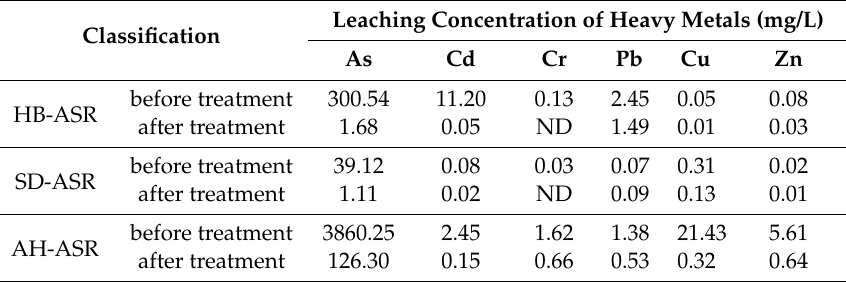
Table 6. Leaching concentration of heavy metals in the raw and treated ASRs.